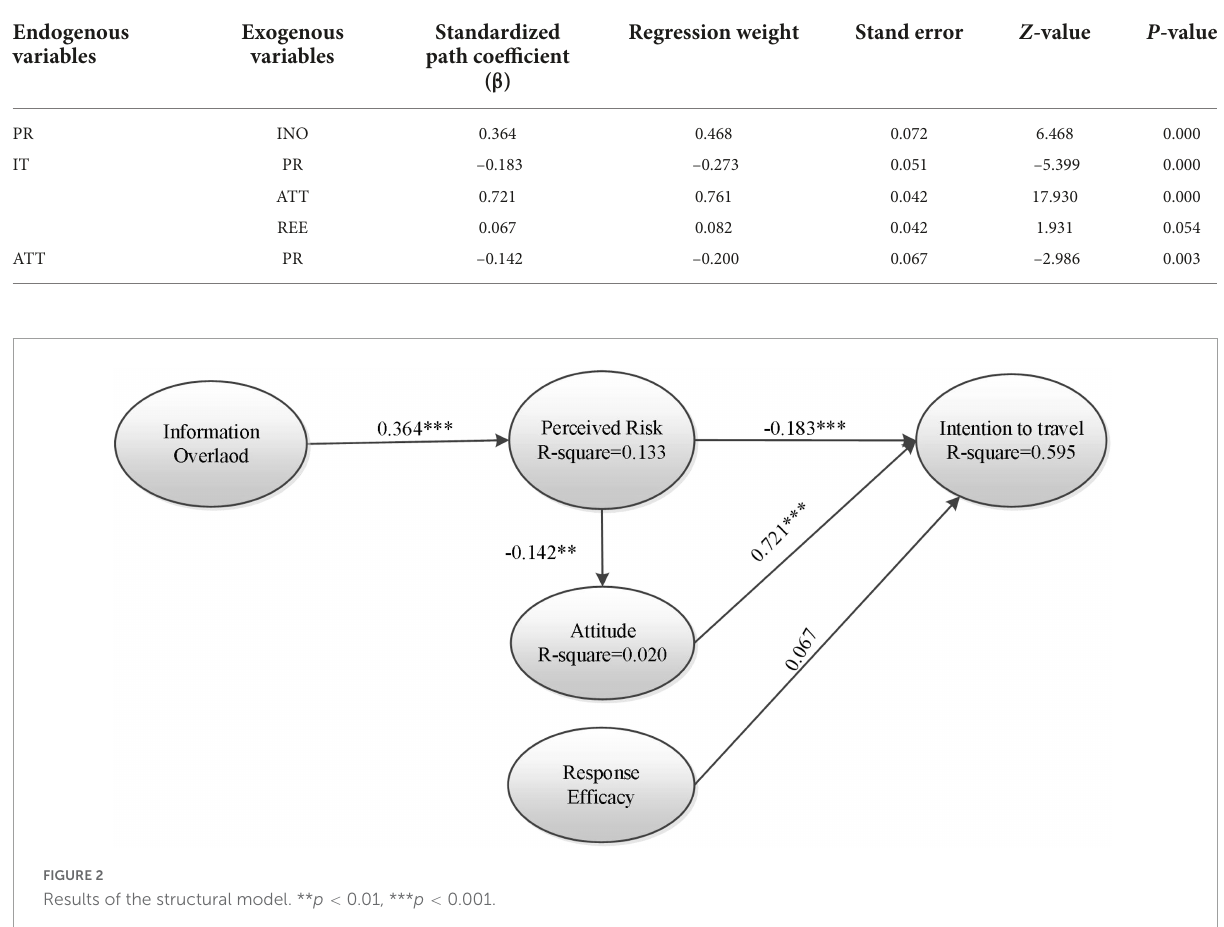
TABLE 7 Research hypotheses testing.